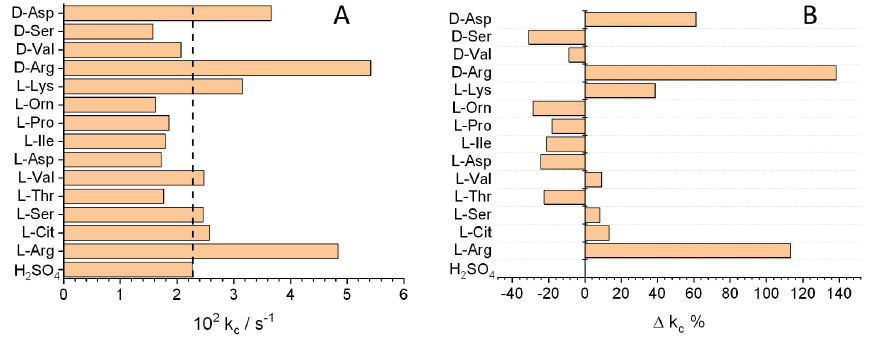
Figure 3. Bar graph of ( A ) the values for the autocatalytic rate constant k c for the aggregation of TPPS 4 induced by H 2 SO 4 in the presence of amino acids (the dashed black line mark the reference value obtained in the absence of added amino acids); ( B ) the percent deviation of k c with respect to the reference value measured in the presence of H 2 SO 4